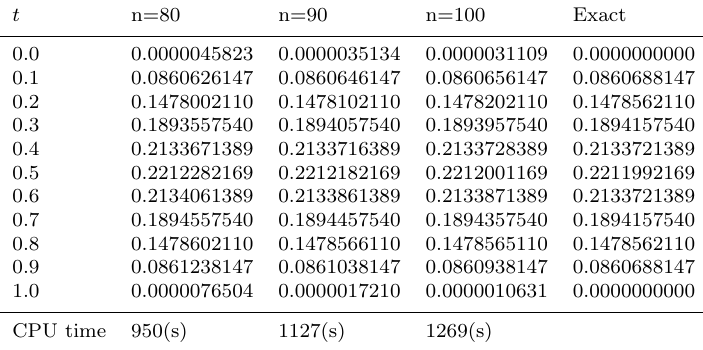
Table 3. Estimated and exact value of x ( t ) for n = 80 , 90 , 100 of Example